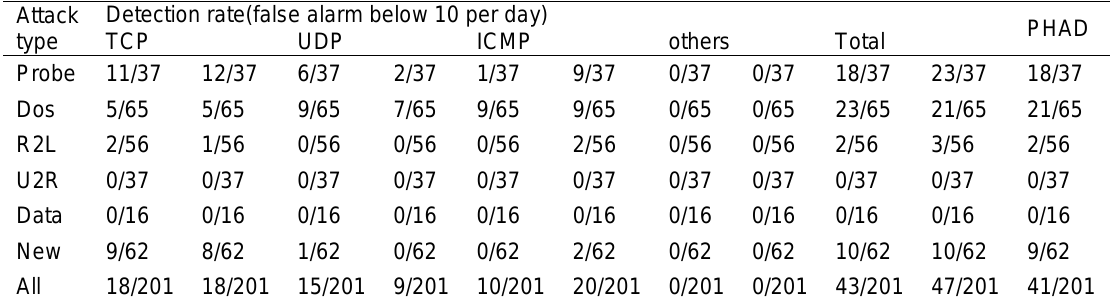
Table 2 the protocol load